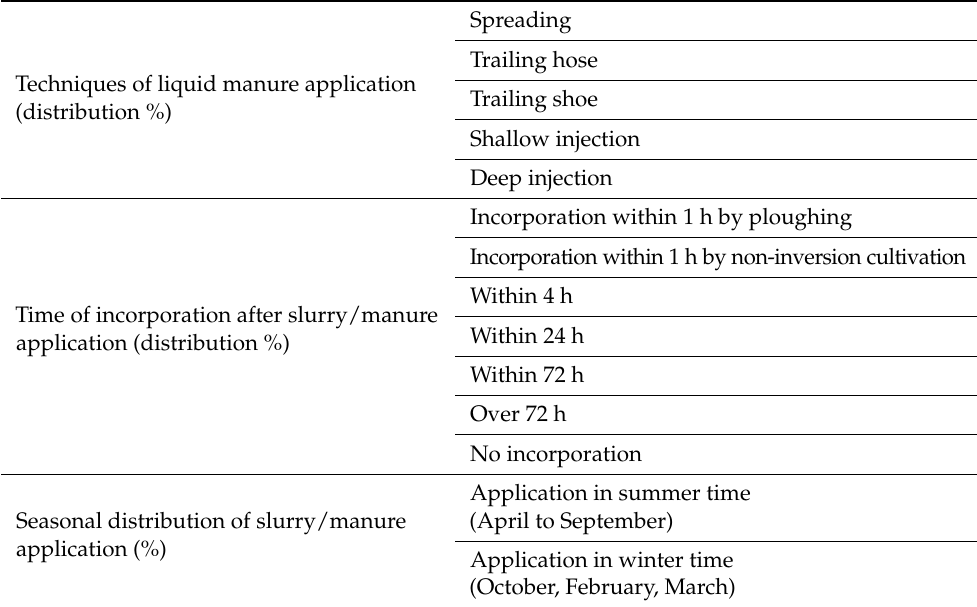
Table 6. The input data requirements of manure application